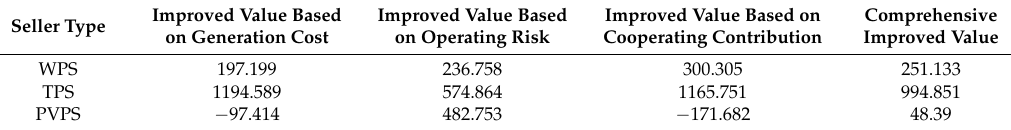
Table 9. Income distribution results based on the improved Shapley value method.